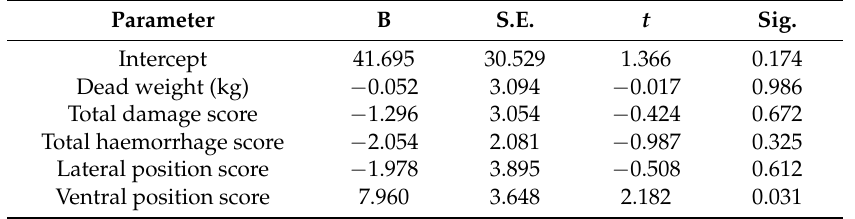
Table 2. Parameter estimates from the GLM testing for an effect of dead weight (kg), total damage score, total haemorrhage score and lateral and ventral shot position scores on time to loss of movement (s).